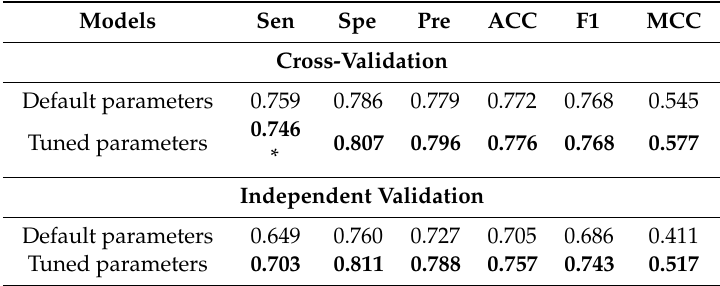
Table 3. Comparison of the prediction performance before and after parameter tuning through cross-validation and independent